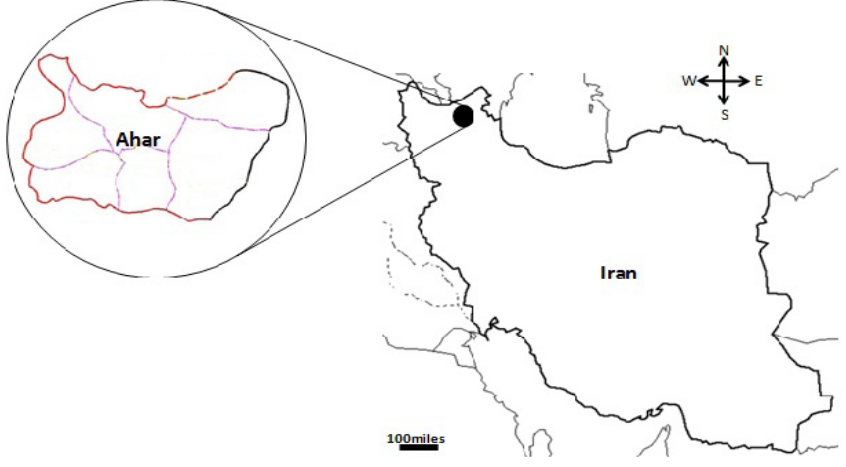
Figure 1. Map of Iran, East Azerbaijan province,